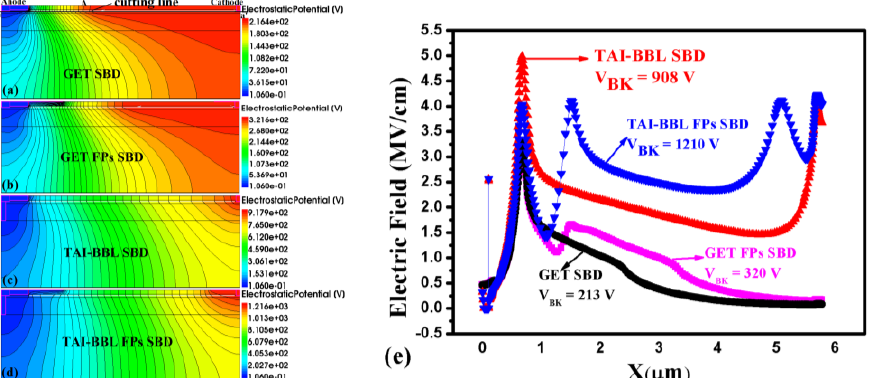
Figure 4. The equipotential line profile of: ( a ) GET SBD, ( b ) GET FP SBD, ( c ) TAI-BBF SBD, ( d ) TAI- BBF FP SBD when breakdown occurs, ( e ) The corresponding horizontal electric field distribution in the 2DEG area.